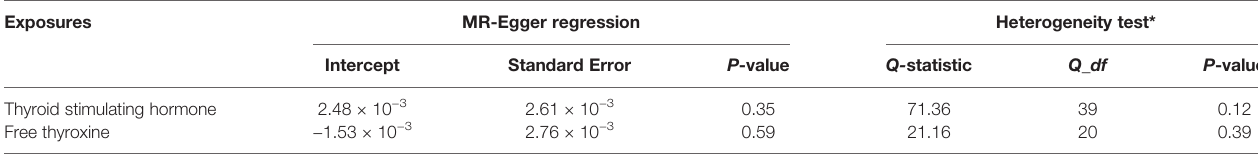
TABLE 1 | Primary statistics in Mendelian randomization sensitivity analyses. Exposures